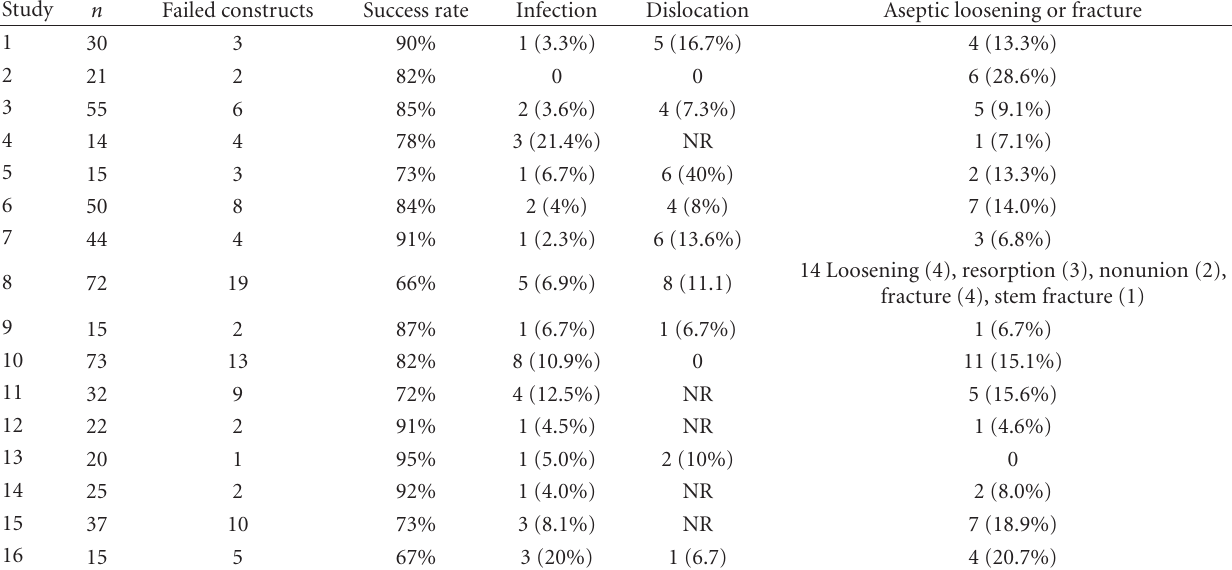
Table 4: Table showing complications of prosthesis into allograft to form the allograft prosthesis composite (APC) and methods for securing APC to distal host femur. The total cohort included 498 patients with a mean follow up of 8.1 years (range 2 to 16.2 years). The pooled